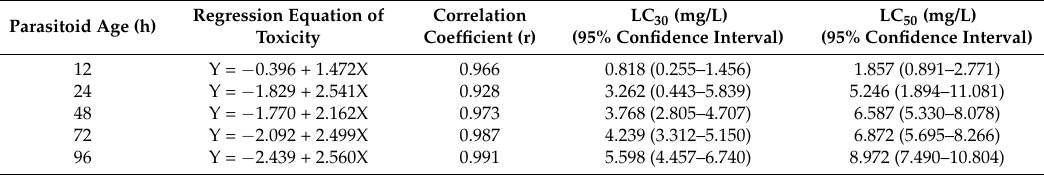
Table 2. Toxicity of abamectin to Encarsia formosa adults.